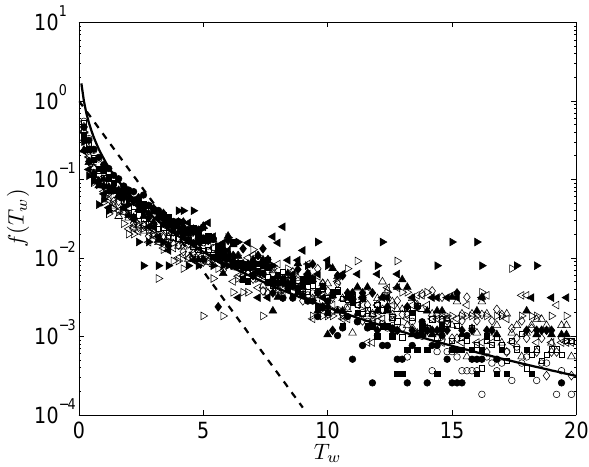
Fig. 8. PDFs of dimensionless waiting times between downward (filled symbols) and upward (open symbols) extreme fluctuations. Different symbols represent different stability ranges, which are the same as those in Fig. 3a. Line is the stretched exponential distribution with the same parameter as that in Fig. 8a and dashed line is the exponential PDF with a mean of 1.